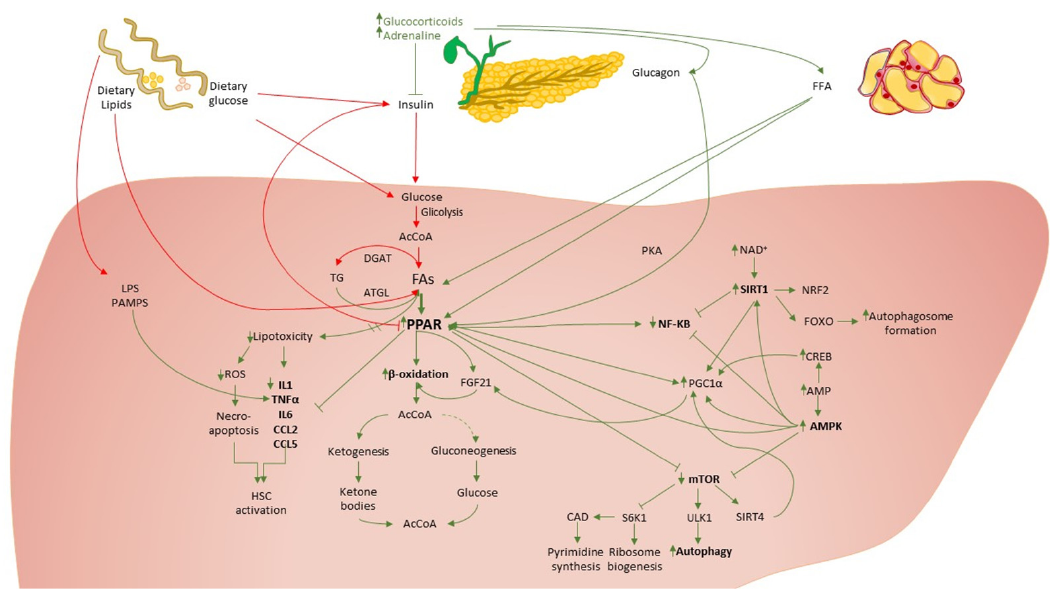
Figure 1. The molecular mechanisms involved in fasting response. LPS: lypopolysacharides,: reactive oxygen species, IL1: interleukine 1, TNF α : tumor necrosis factor α , CCL2, 5: C-C Motif